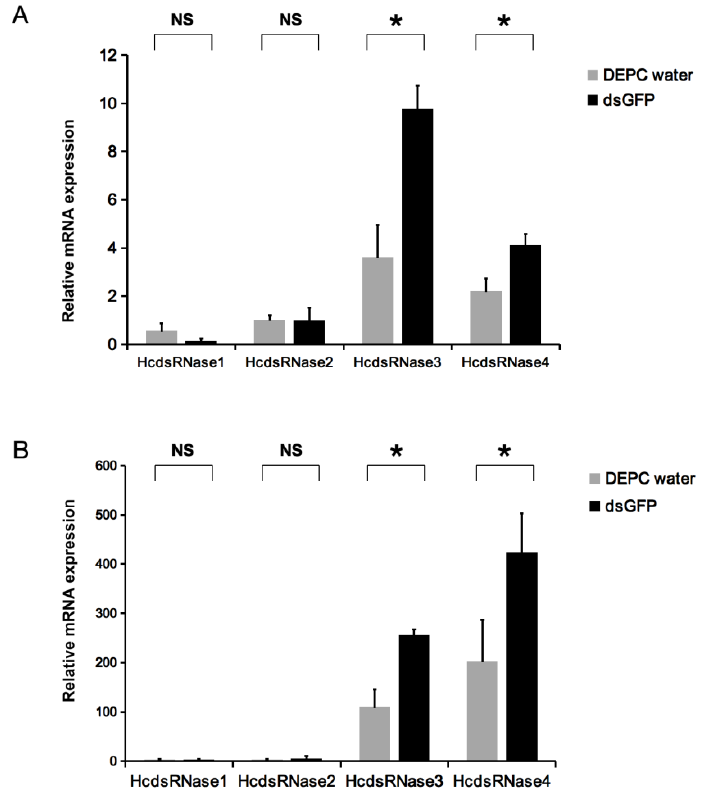
Figure 4. Relative mRNA expression level of the four HcdsRNase genes after dsGFP injection at ( A ) 24 h and ( B ) 48 h. Two-day-old fourth-instar larvae were injected with 2 µ L of 6 µ g dsGFP (black columns, the treatment group) or 2 µ L DEPC water (gray columns, the control group). Error bars represent the standard error of the calculated means based on four replicates. * Asterisks indicate significant differences ( p < 0.05). NS means no significant differences.